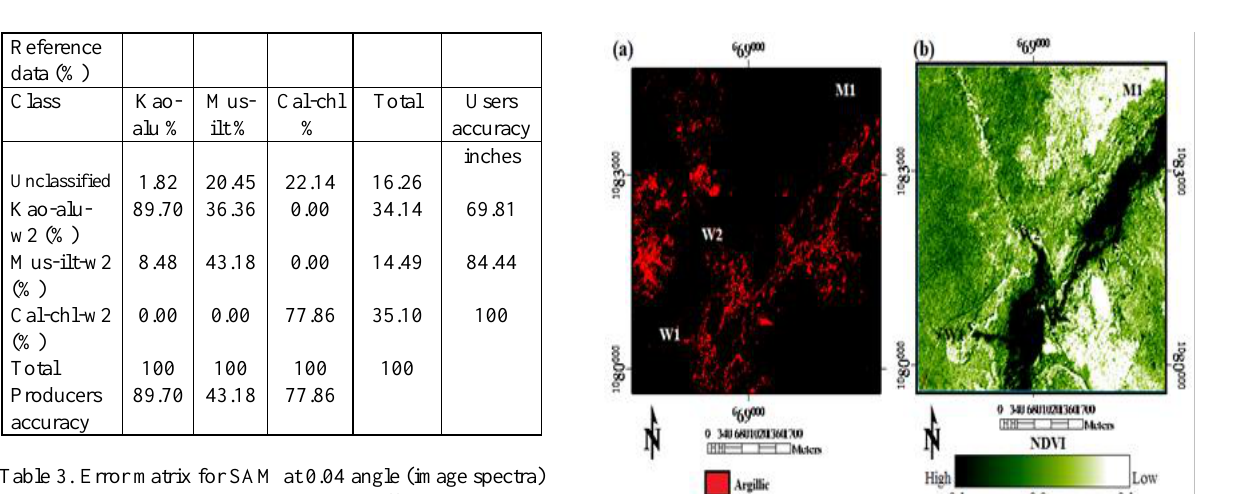
Table 3. Error matrix for SAM at 0.04 angle (image spectra) Overall Accuracy = 71.1%; Kappa Coefficient = 0.59